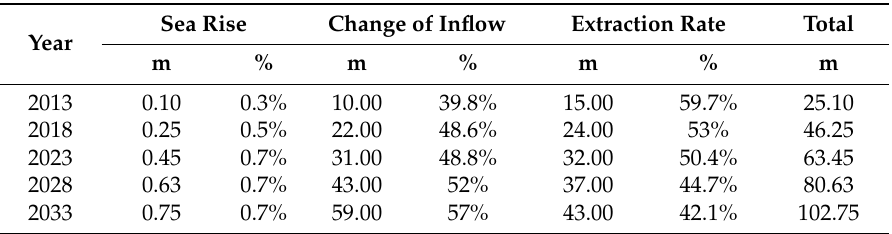
Table 7. Proportion of impact for each parameter in scenario (B).